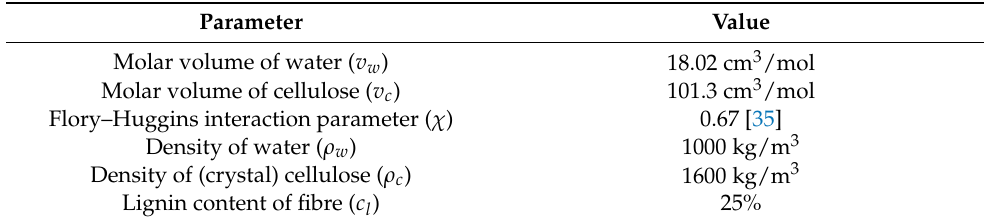
Table A1. The values of the parameters used for plotting the vapour pressure as a function of temperature and solids content in Figure